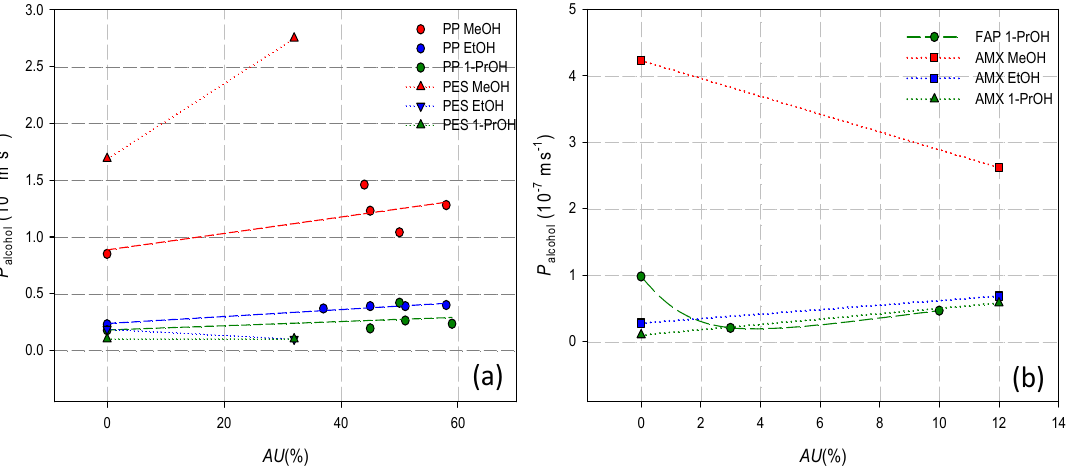
Figure 5. Alcohol permeability as a function of the doping capacity. ( a ) Heterogeneous membranes. ( b ) Homogeneous membranes.